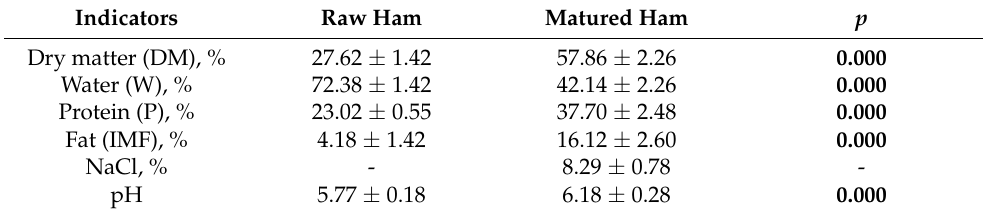
Table 1. Influence of processing on basic-chemical properties (means ± standard error) of raw and matured Istarski pršut of (LWxL)xD genotype.